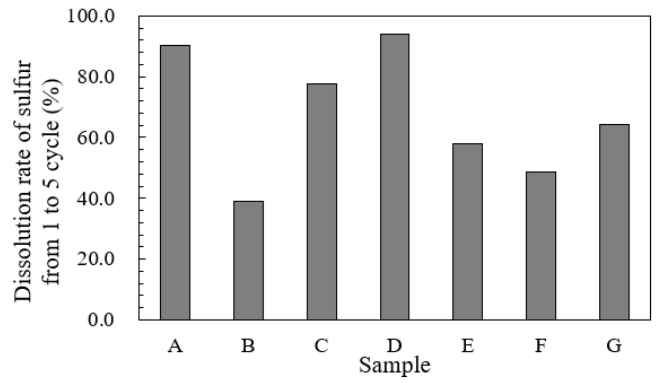
Figure 9. Proportion of the total amount of dissolved sulfur for the first five leaching cycles in the leaching test. The proportion is calculated based on the ratio of the total dissolved sulfur during the first five leaching cycles to the amount over 40 leaching cycles. Table 2. Changes in NAG pH during the sequential NAG test.